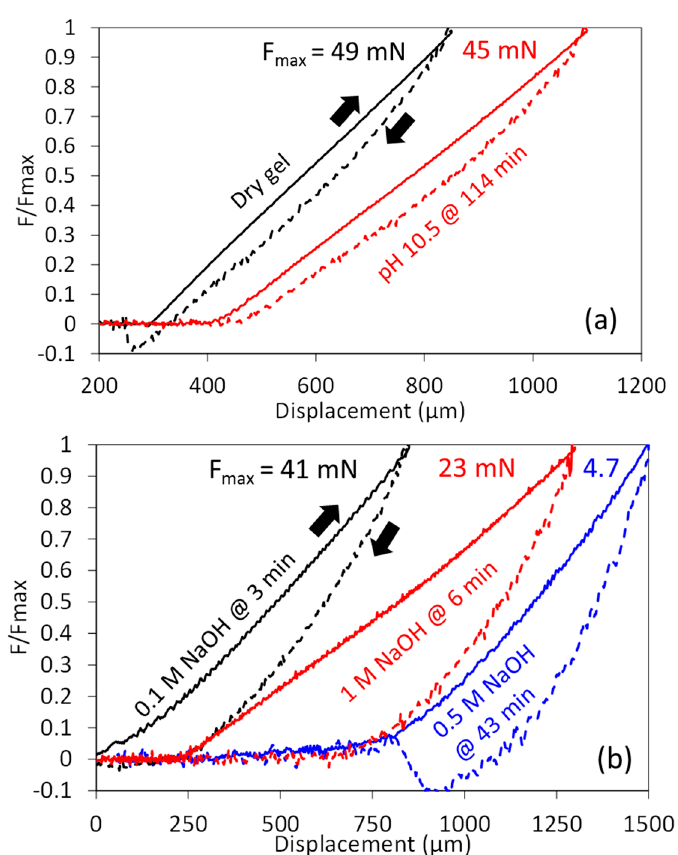
Figure 11. Typical loading-unloading indentations, continuous and dashed lines respectively. ( a ) Gels tested dry or swollen at low alkaline pH; ( b ) gels undergoing dissolution at high [NaOH]. For clarity, the force is normalized with the maximum force, shown at the top, and some data has been shifted horizontally to avoid overlapping.